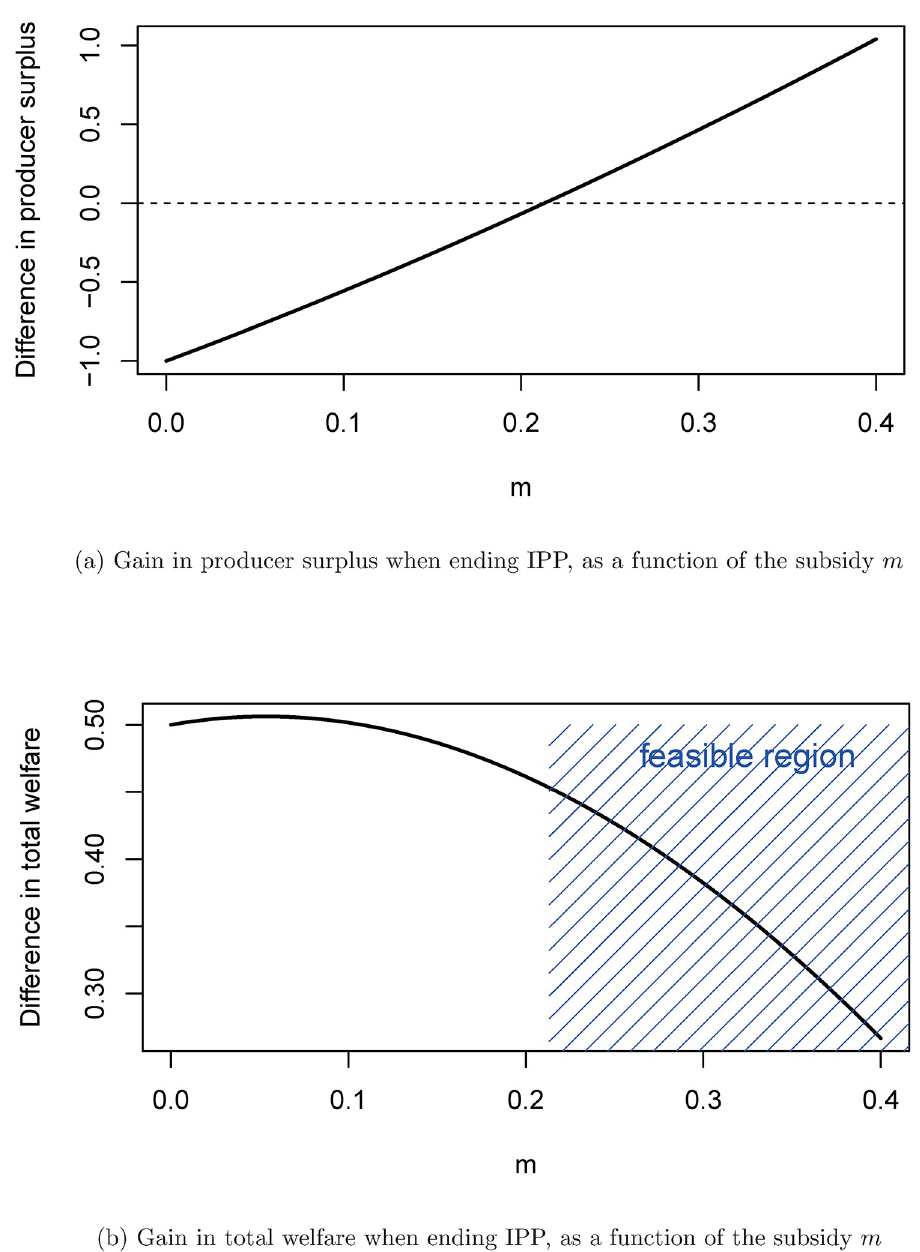
Fig 5. Producer surplus and total welfare when ending IPP, in dependence of the subsidy. (a) Gain in producer surplus when ending IPP, as a function of the subsidy m , (b) Gain in total welfare when ending IPP, as a function of the subsidy m